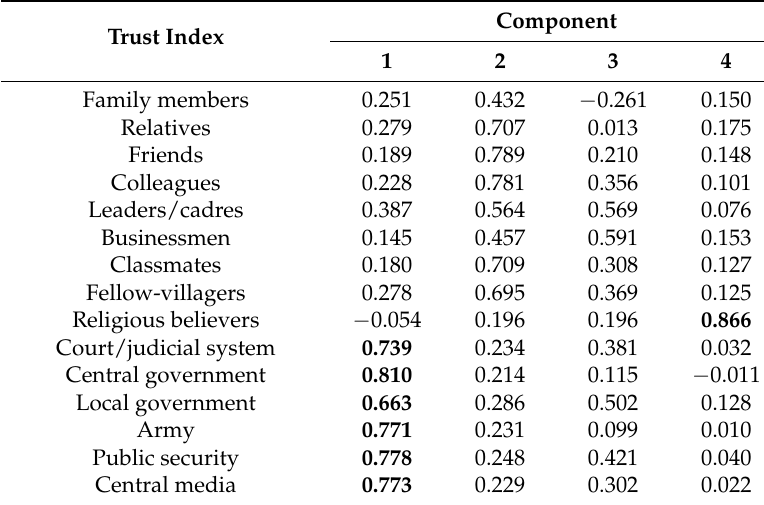
Table 1. Factor analysis of trust